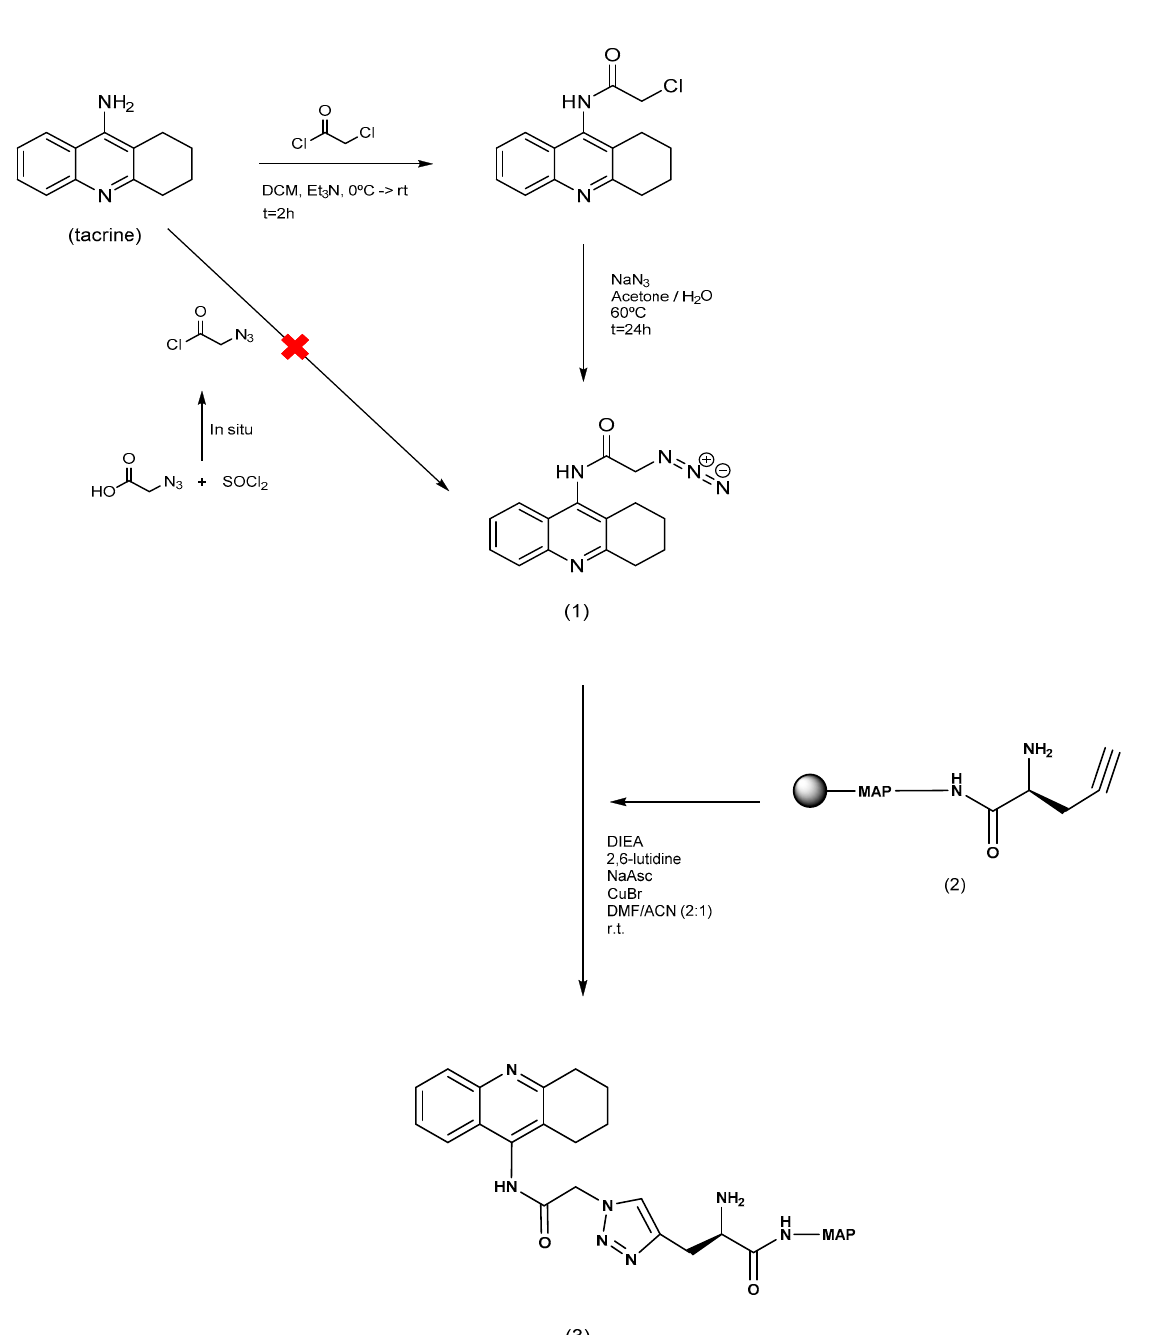
Scheme 1. Representation of the methodology applied for the synthesis of the Tacrine-MAP conjugate by SPPS. Tacrine-MAP ( 3 ) was obtained with a high level of purity (99.6%). Red cross means that the reaction was executed but did not evaluated. Synthetic details, analytical and spectral data are supplied as Supplementary Information (SI, Figures S1–S15).